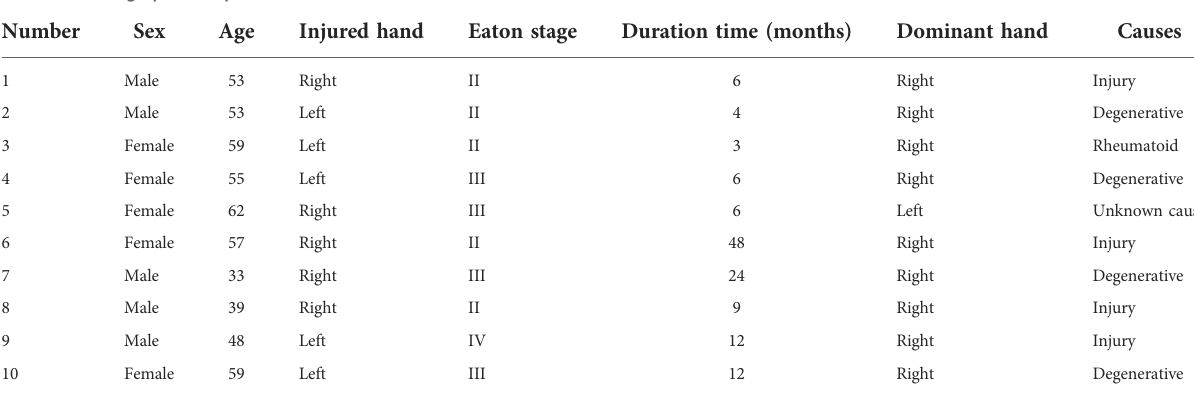
TABLE 1 Demographics of patients at